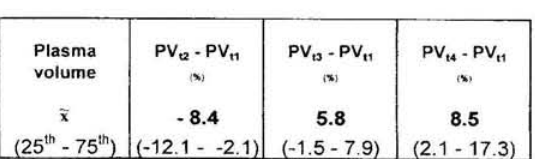
Table 3: Percentual changes in plasma volume (PV) immediately after the r¿;e ι PY-j-PVti 1. 3h after (PVt3-P\':: ) ar.d 3-ih · PVy-PVti) after exercise termi- nation. Data given as percentual changes and the 25 th and 75°" percentiles in brackets, respectively.